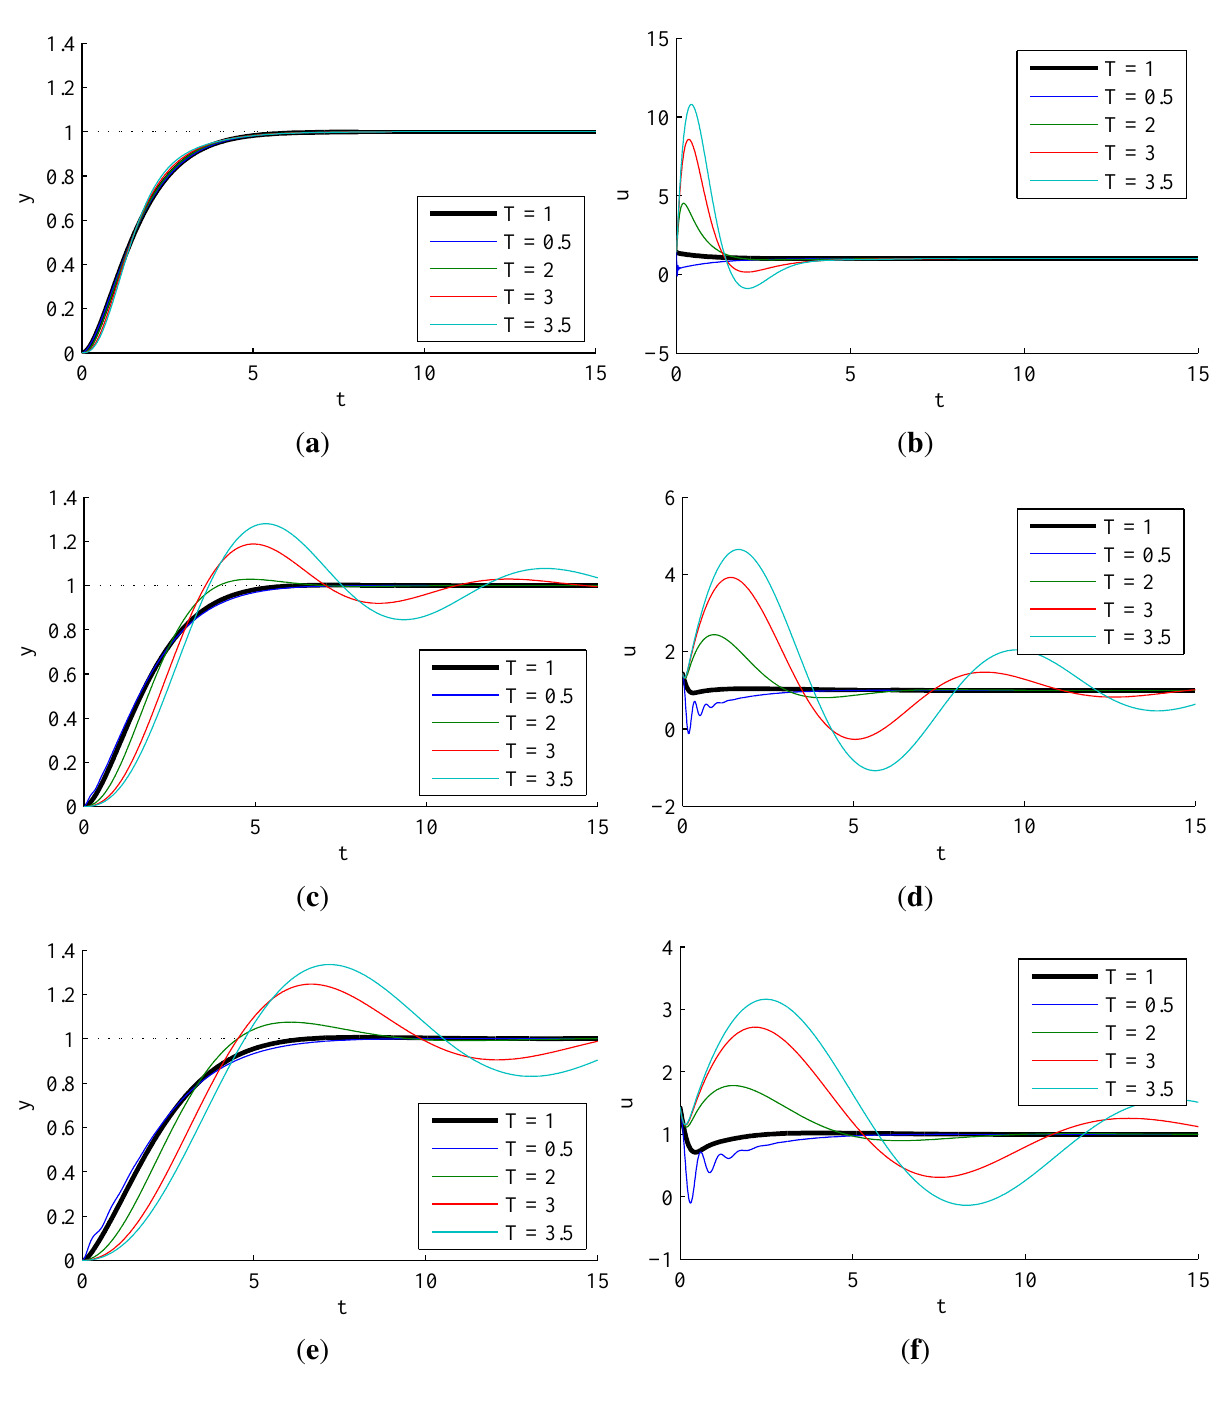
Figure 12. Experiment 3.2.2: effect of observer pole locations for a second-order ADRC controlling second-order processes with varying parameter, T . Nominal process parameters: = K = 1, T = 5, s ESO varying. ( a ) Closed K = 1, D = 1, T = 1. ADRC parameters: b 0 settle T 2 s CL ; ( b ) Controller output u for ( a ); ( c ) Closed loop step loop step response, s ESO = 100 · s CL ; ( d ) Controller output u for ( c ); ( e ) Closed loop step response, response, s ESO = 10 · s ESO = 5 s CL ; ( f ) Controller output u for ( e ·